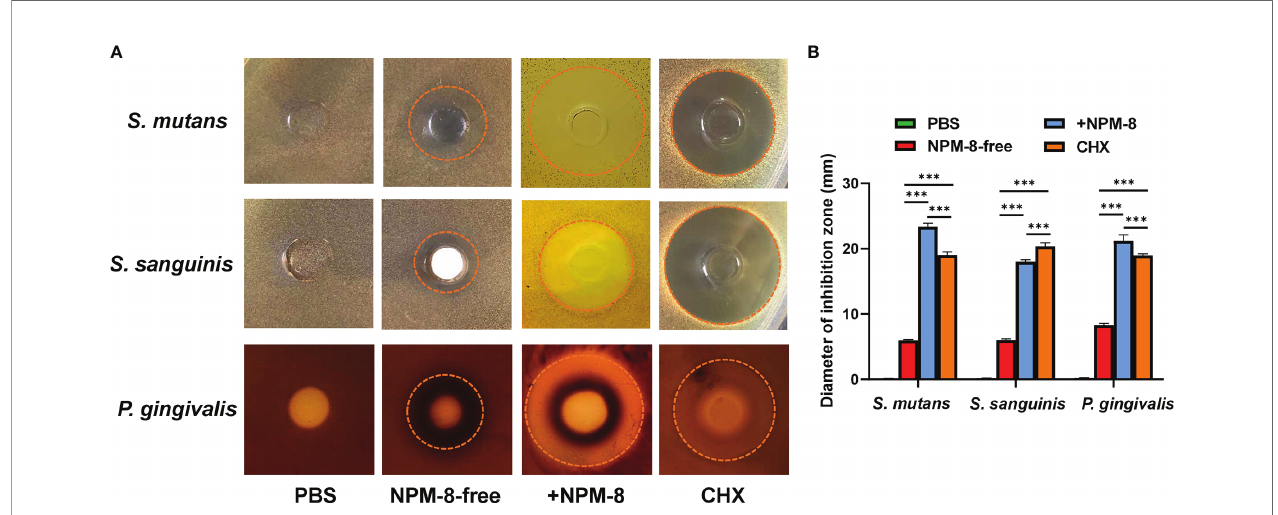
FIGURE 2 | Results of the Oxford cup bacteriostatic test. (A) Representative images of the inhibition zone of S. mutans, S. sanguinis and P. gingivalis treated with PBS, NPM-8-free toothpaste, NPM-8-containing toothpaste and CHX. (B) The diameters of the inhibition zones with different test agents against S. mutans , S. sanguinis and P. gingivalis. Data are presented as means ± SD. *** P <